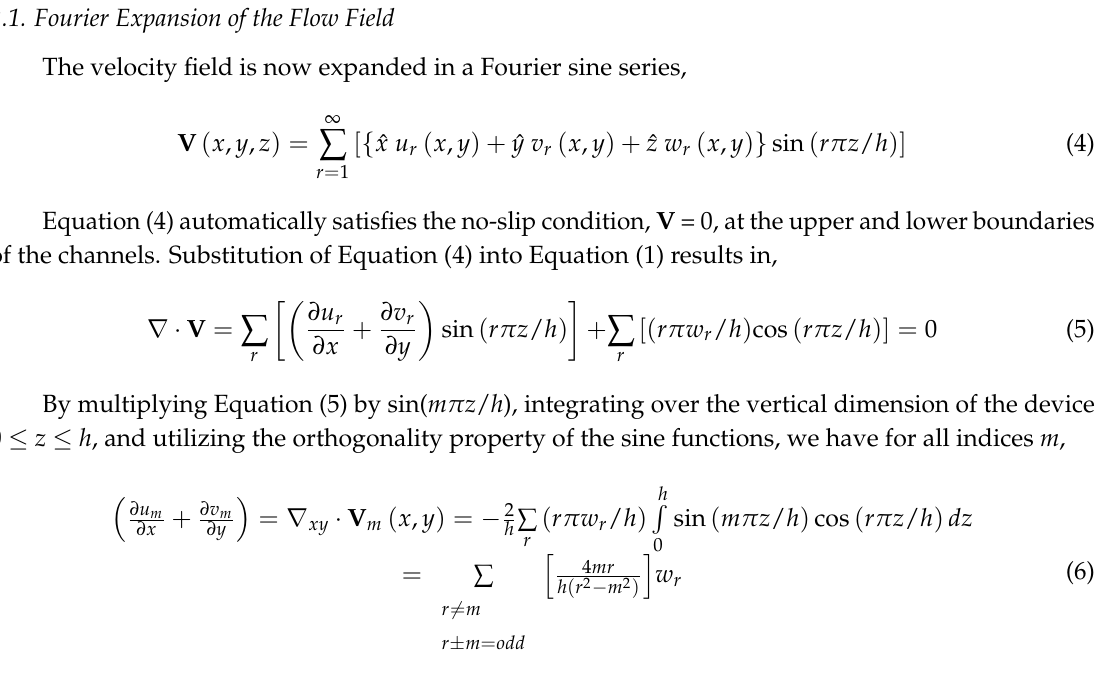
Figure 1. ( a ) Detail of the silicon master formed by reactive ion etching for replicating rectangular microchannels in PDMS; ( b ) Schematic of an x-y planar system of rectangular microchannels of height h .